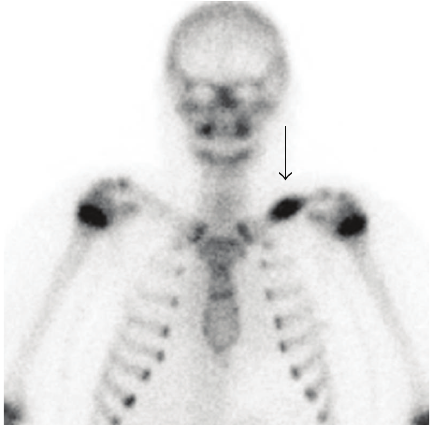
Figure 2: A Tc-99m-MDP bone scan AP image shows intense focus of radioisotope accumulation within the mid-left clavicle (arrow). Incidental radioisotope uptake from dental disease and normal increased uptake in bilateral proximal humerus physis in a skeletally immature patient is seen.